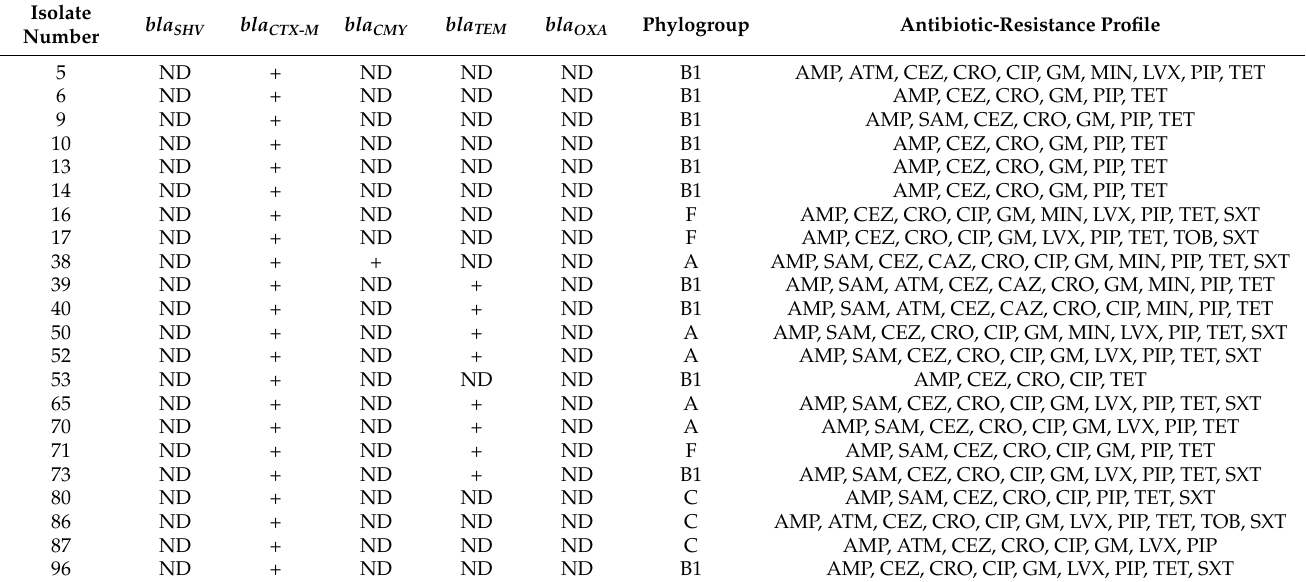
Table 2. Molecular characterization and antimicrobial resistance profile of bla CTX-M -positive Es- cherichia coli isolates ( n = 22) derived from chicken meat.